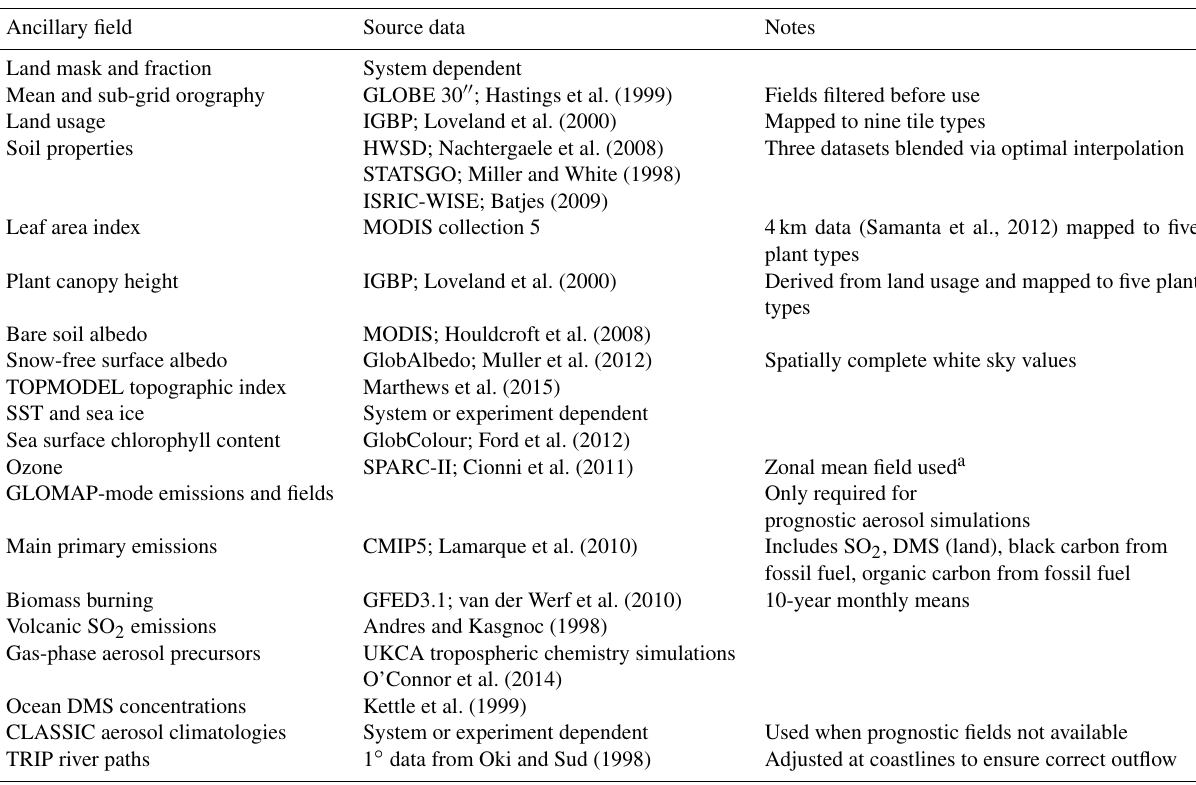
Table 3. Source datasets used to create standard ancillary files used in